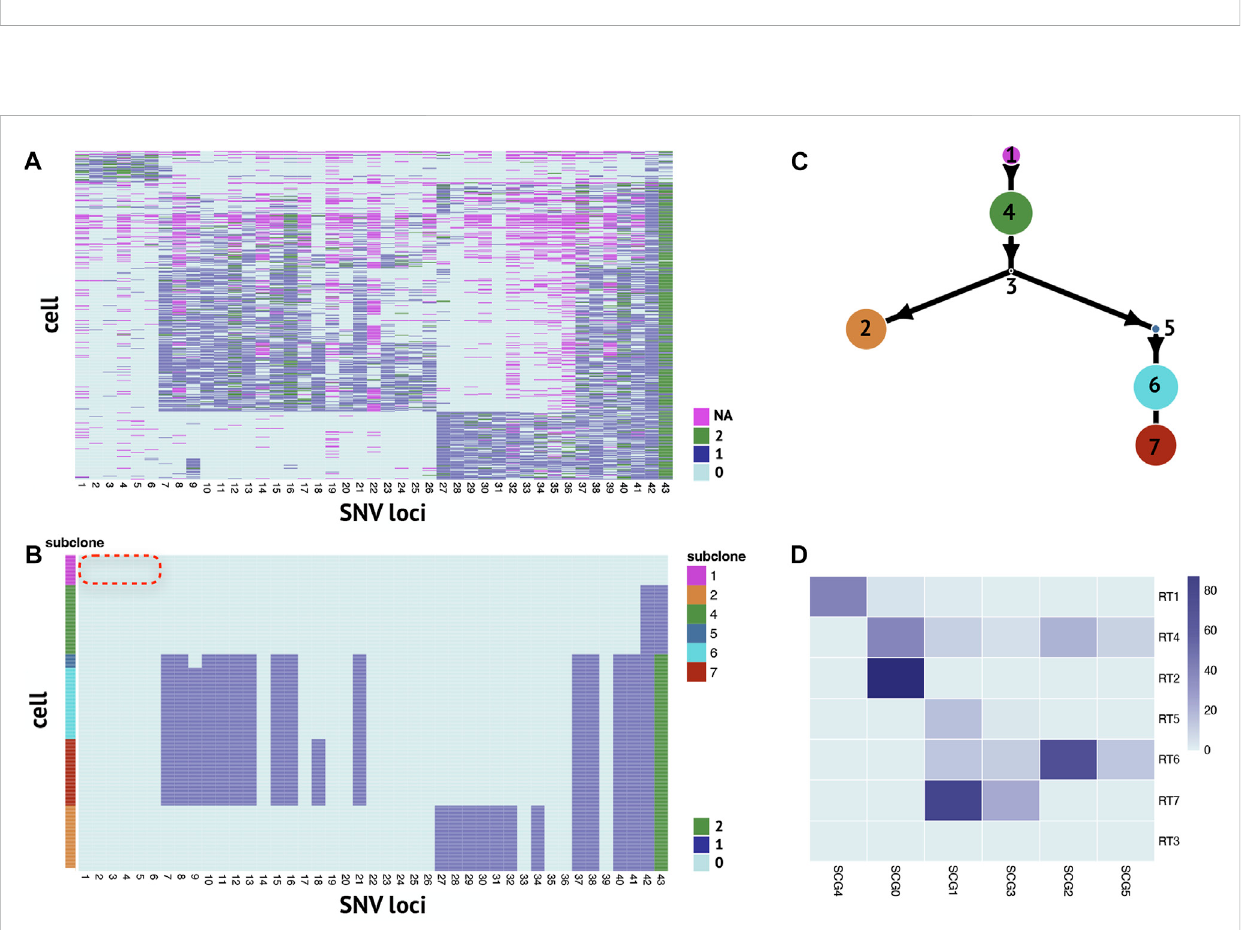
FIGURE 4 RobustTree reconstructs the tumor evolutionary tree on single-cell high-grade serous ovarian cancer data. (A) Observed noisy SNV genotype matrix. (B) Recovered SNV genotype matrix by RobustTree. (C) Subclone evolutionary tree reconstructed by RobustTree. (D) Heatmap shows the percentage of cells in each subclone (y-axis) distributed into SCG subclones